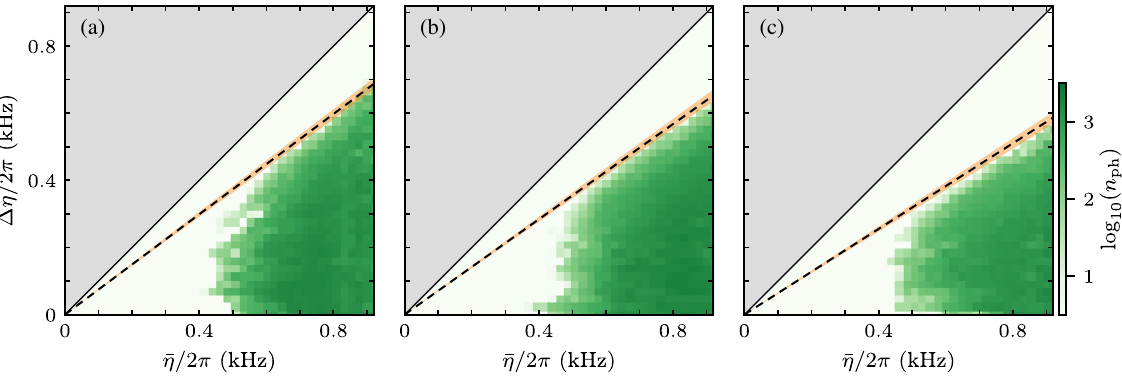
= 2 π ¼ − 5 . 0 ð 2 Þ (a), − 4 . 0 ð 2 Þ (b), and − 3 . 0 ð 2 Þ MHz (c). For these c as described in the text. DSNP